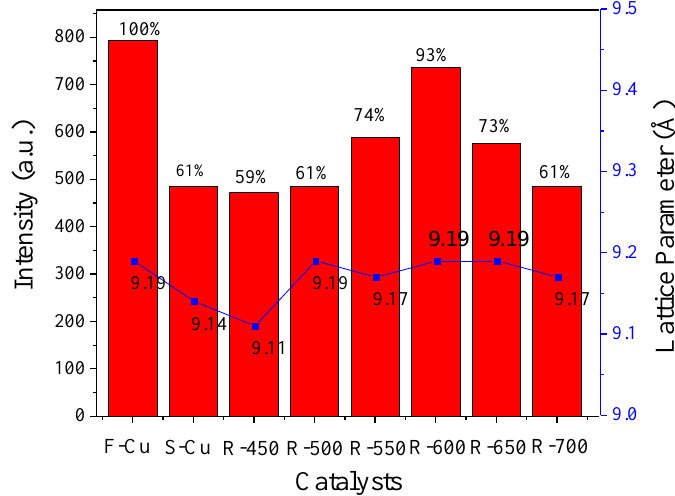
Figure 2. The relative crystallinity and lattice parameter of Cu-SSZ-13 catalysts in fresh, sulfated and regenerated states.